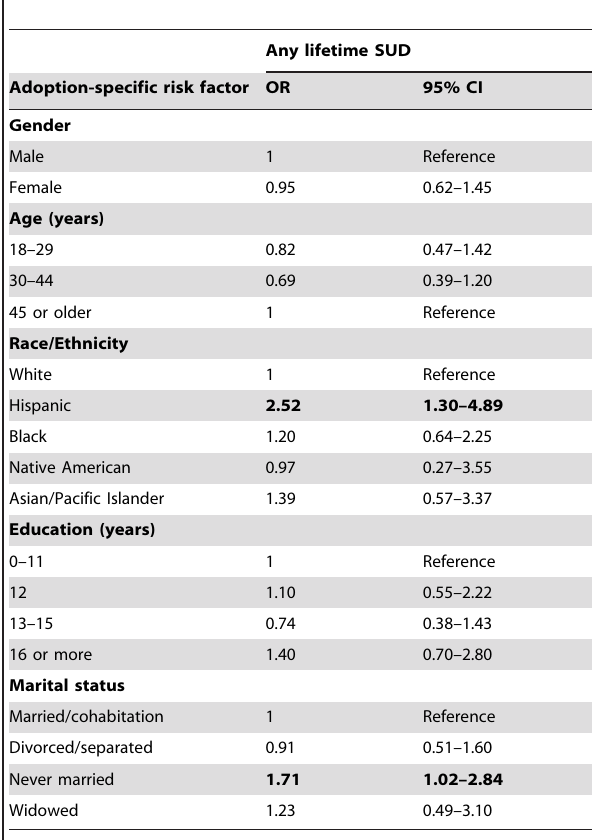
Table 3. Logistic regression of adoption-specific risk factors associated with any lifetime SUD in all individuals